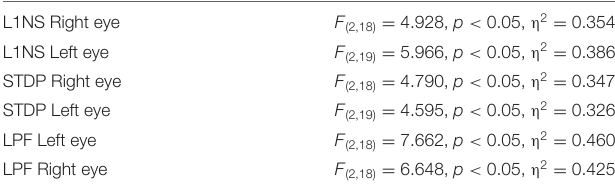
TABLE 6 | Repeated measure one-way ANOVA for each metric with effect